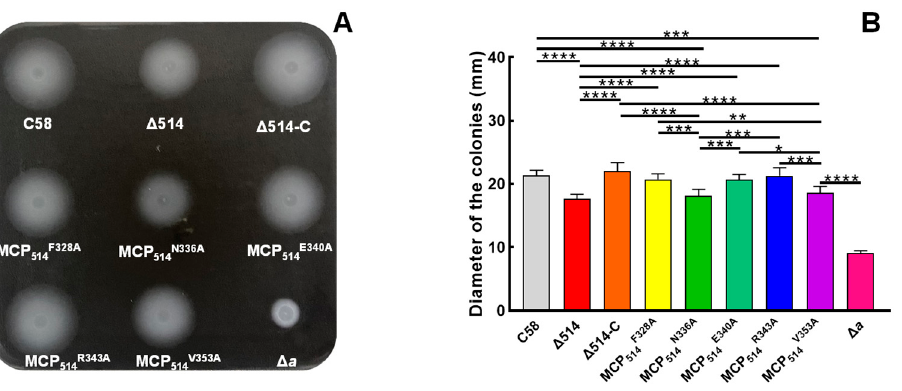
Figure 8. Effects of MCP 514 variants on the chemotactic response of A. fabrum . The test procedure was the same as described in Figure 3. ( A ) Typical colonies of these tested A. fabrum strains. ( B ) The swim-ring diameters of these tested A. fabrum strains on the swim plate. The data represent the means ± SDs from five independent experiments in triplicate. The bars paired with “*”, “**”, “***” and “****” marks represent that they are different in a statistical manner at p < 0.05, 0.01, 0.001 and 0.0001, respectively, via the one-way ANOVA, followed by Tukey test. C58, A. fabrum wildtype C58 strain; ∆ 514, MCP 514 deficient mutant; ∆ 514-C, ∆ 514 mutant complemented with native MCP 514 ; MCP 514F328A , MCP 514N336A , MCP 514E340A , MCP 514R343A and MCP 514V353A represent ∆ 514 mutant complemented with the corresponding single residue-substituted MCP 514 variants, respectively; ∆ a , CheA deficient mutant.